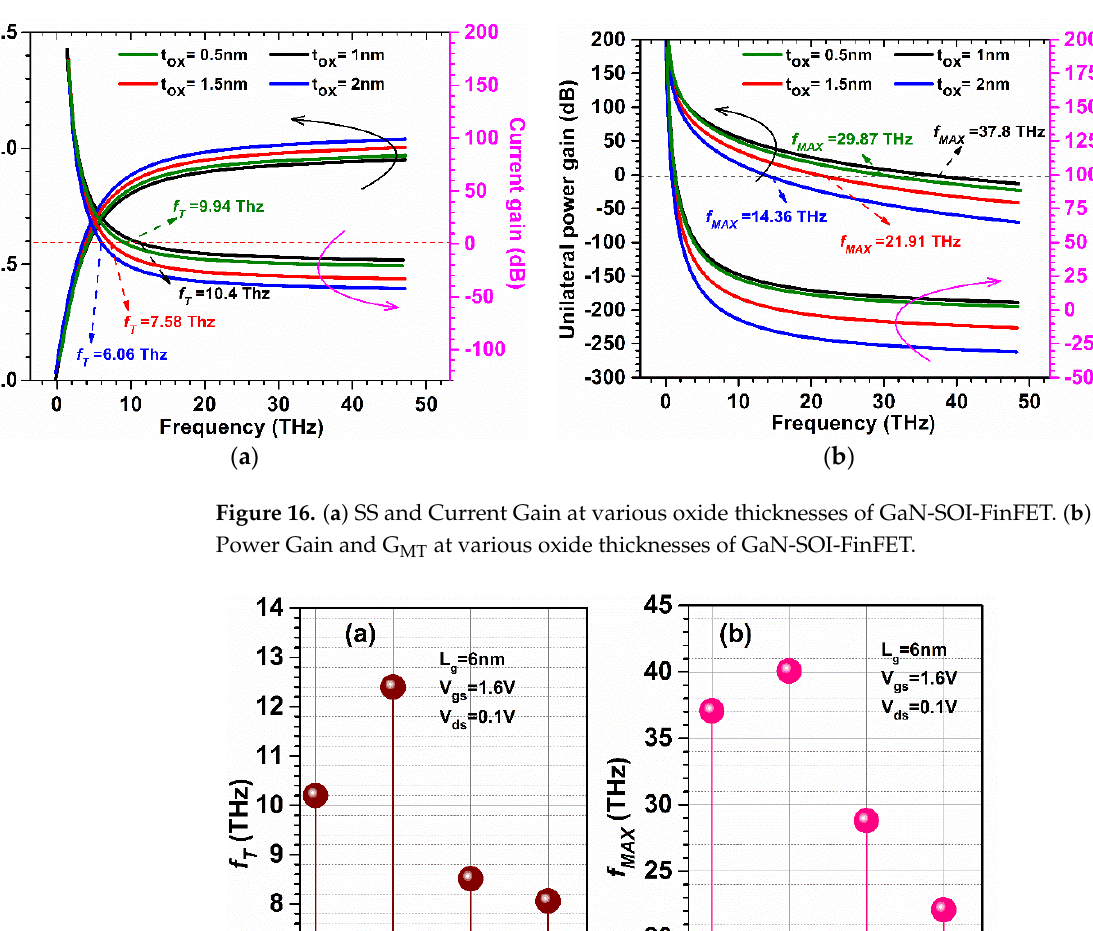
Figure 18. Intrinsic delay at various oxide thicknesses of GaN-SOI-FinFET. Figure 19a shows that GFP is slightly reduced (by 4.82%) when oxide thickness is reduced from 1 nm to 0.5 nm; however, more reduction is observed when oxide thick- ness increases to 2 nm (by 15.86%) due to the reduction in f T compared to 1 nm oxide